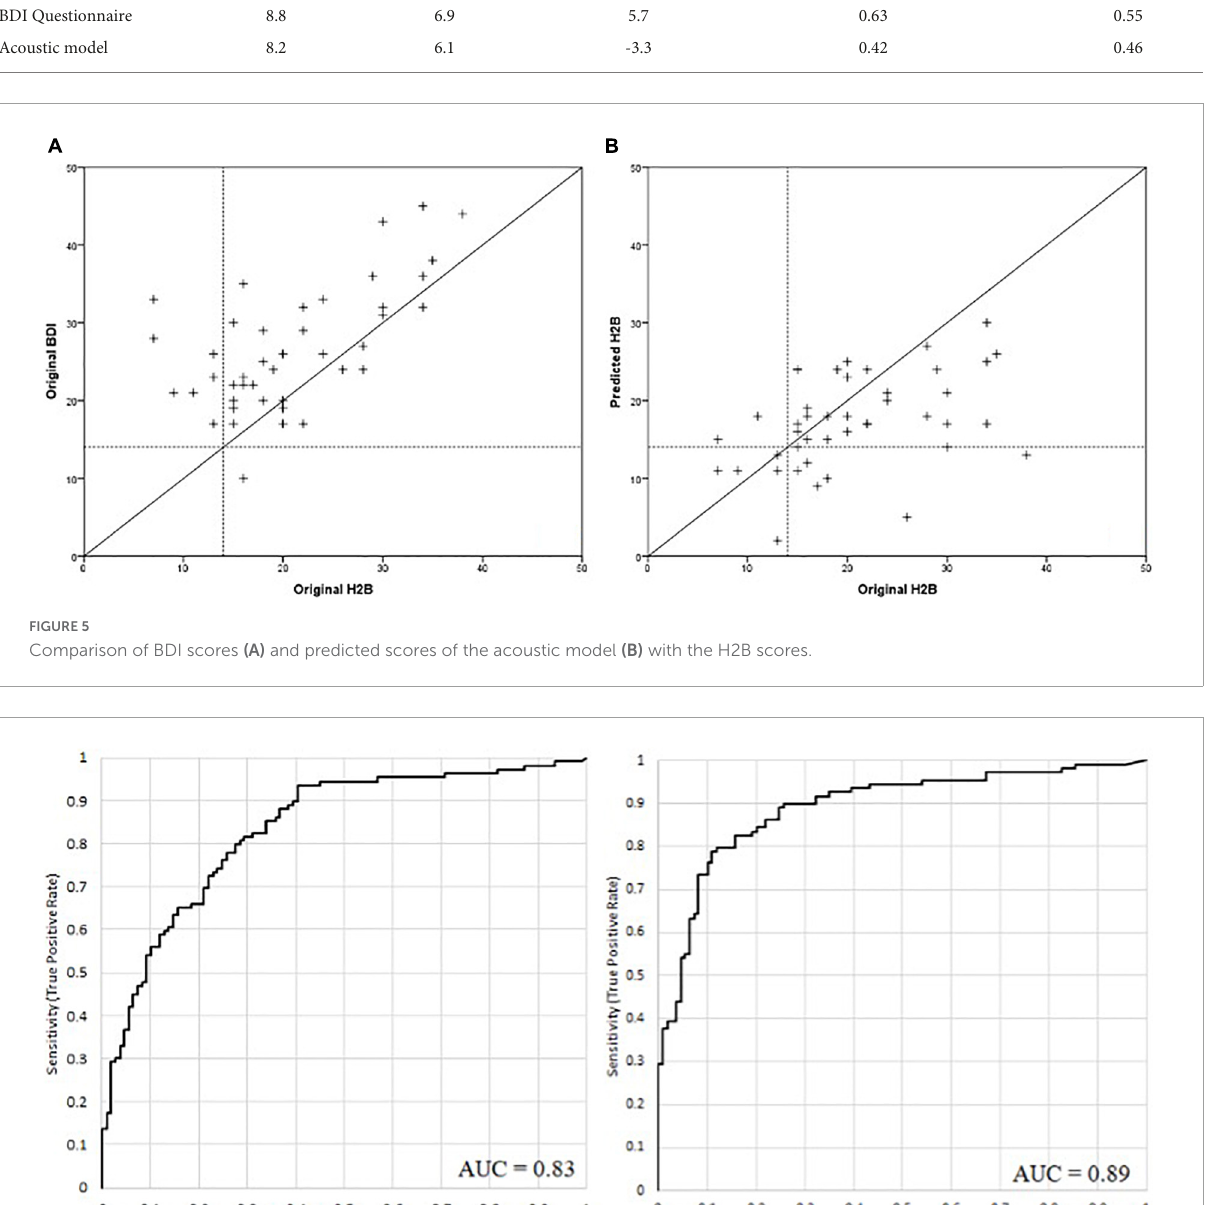
severity of depression. While the acoustic model has slightly lower RMSE and MAE error values ( p = 0.513, paired samples T -test), the BDI questionnaire has a better correlation with the H2B (converted HAMD) score ( p = 0.094, using Fisher’s r